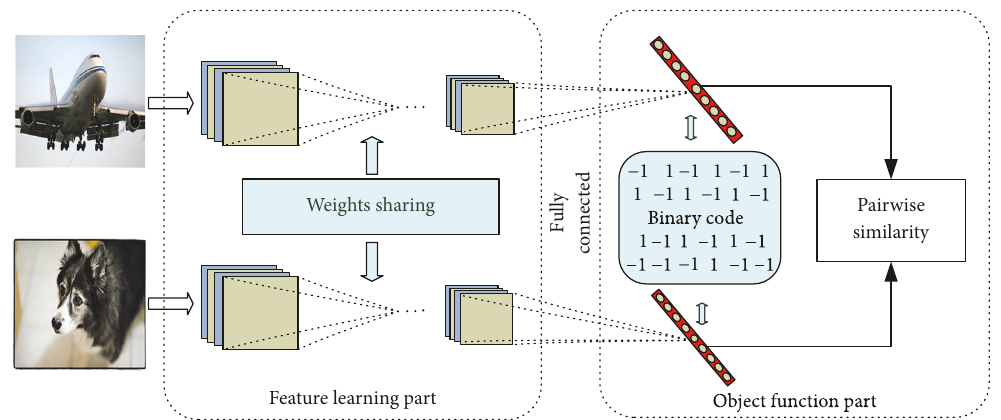
Figure 1: The end-to-end deep hash network learning